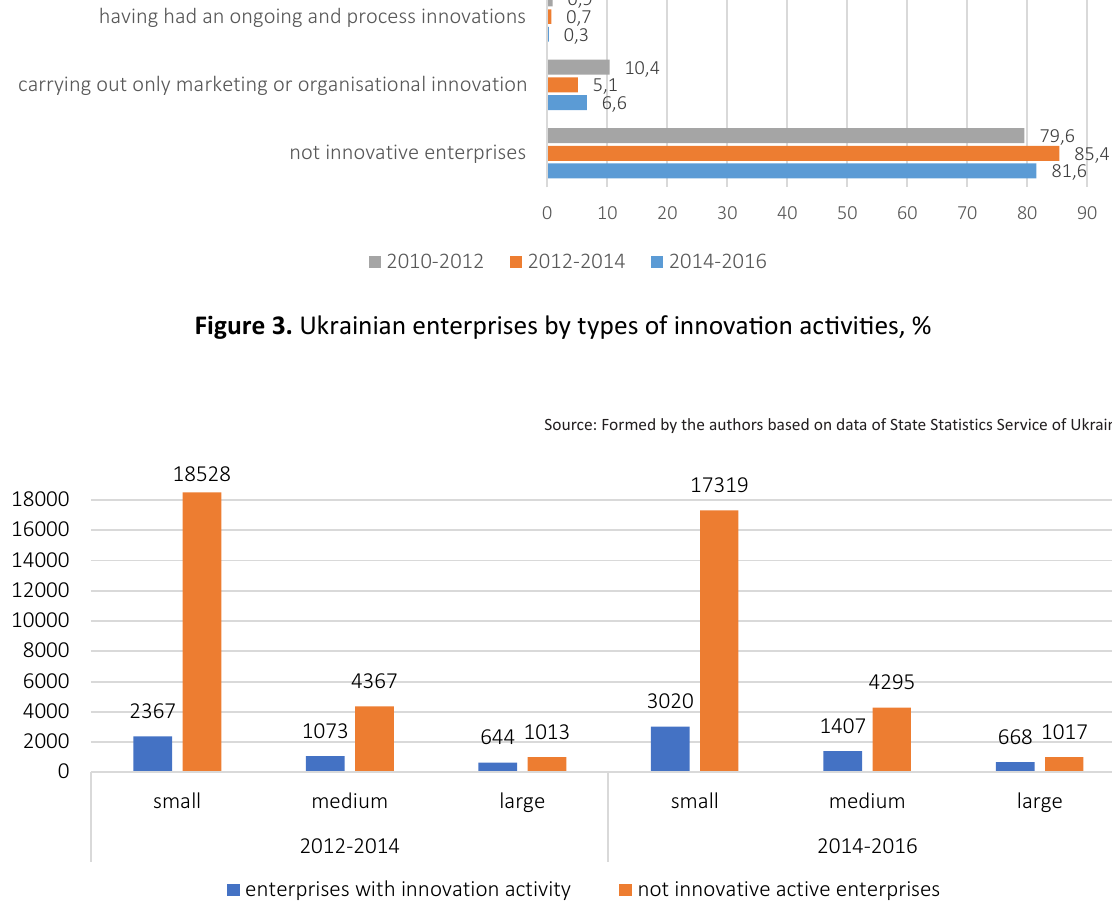
Figure 4. Innovation activity of Ukrainian enterprises for 2012–2016, units